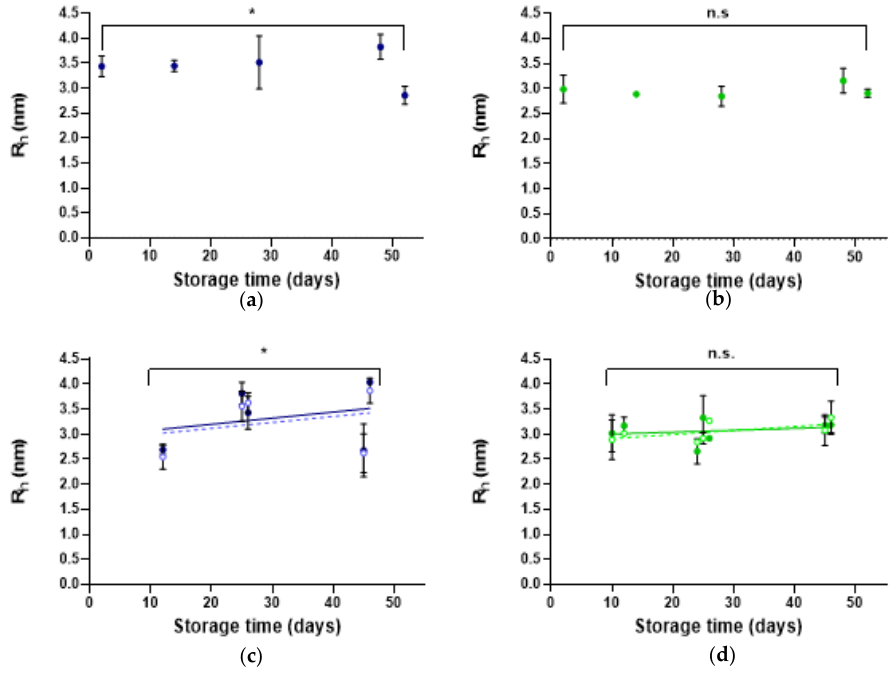
Figure 5. rhCNTF hydrodynamic radius estimates during storage on ice at 4 ◦ C in ( a ) bu ff er M, and ( b ) bu ff er C, and at -80 ◦ C in ( c ) bu ff er M, and ( d ) bu ff er C. Solid circles denote samples that were unmixed after thawing, and open circles denote centrifugally cleared thawed samples. Over time, more variations with the R h of rhCNTF stored in bu ff er M were observed compared to only minor R h variations with rhCNTF stored in bu ff er C. Each value shown as average mean ± SD (n = 3 technical replicates; one-way ANOVA, * p < 0.05, n.s. = no significance).